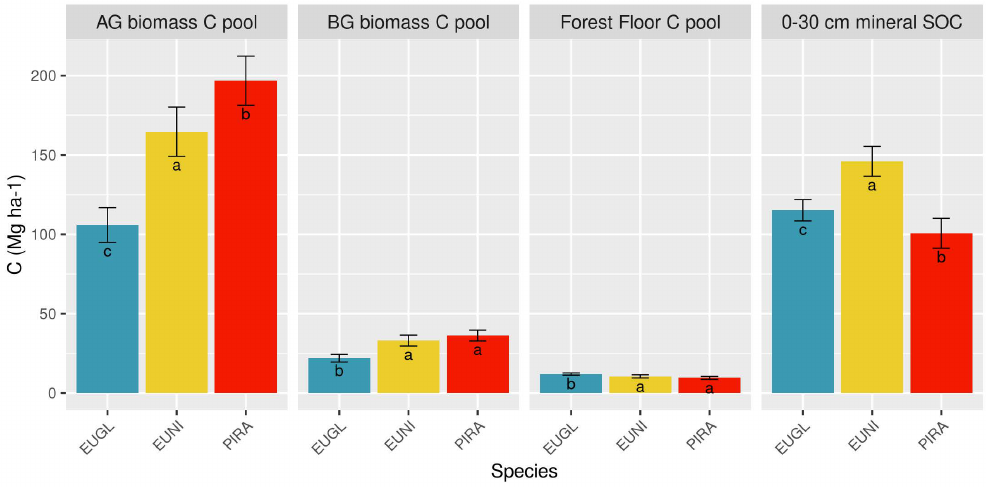
Figure 4. Distribution of carbon stock (mean and confidence interval of the mean) between the four pools (Above-ground biomass (AGB), Below-ground biomass (BGB), forest floor and 0–30 mineral soil organic carbon (SOC)) evaluated for Eucalyptus globulus (EUGL), Eucalyptus nitens (EUNI) and Pinus radiata (PIRA) at rotation age (10–14 years-old for EUGL and EUNI, 20–24 years-old for PIRA). Means denoted by a different letter indicate significant differences for p <